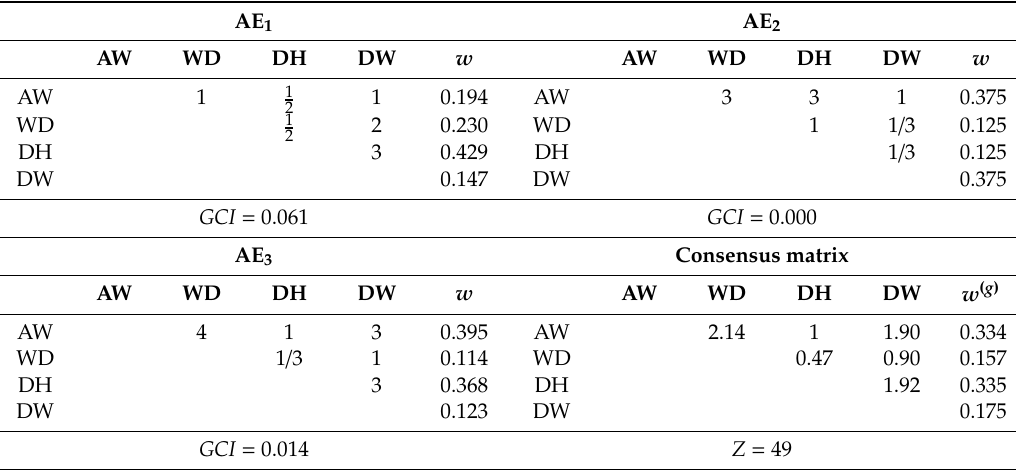
Figure 4. Decision problem hierarchy. Table 3. Individual judgment matrices (AE 1 –AE 3 ) with priority vectors, and consensus matrix with group priority